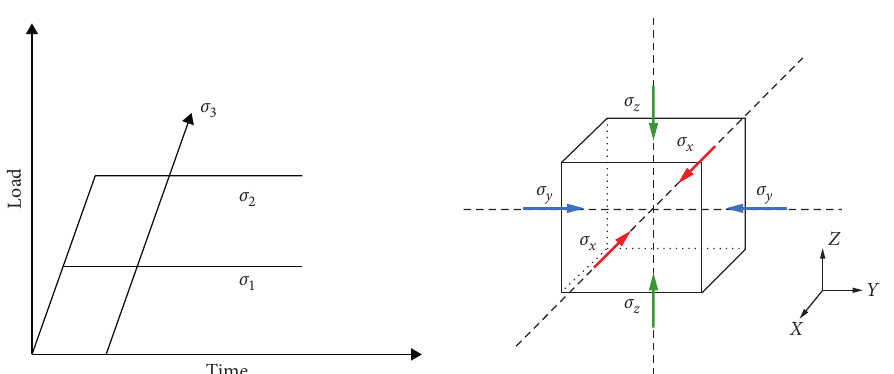
Figure 5: Loading model of true triaxial static compression